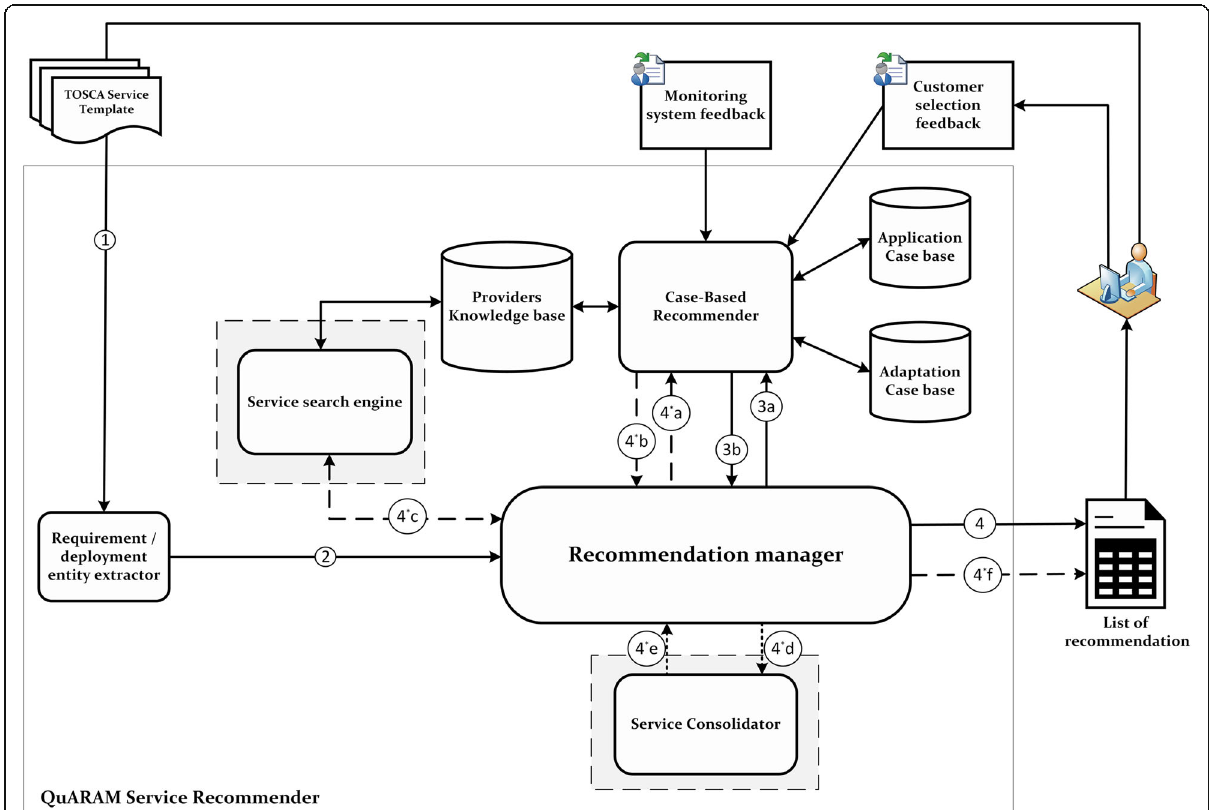
Fig. 3 The architecture of QuARAM Service